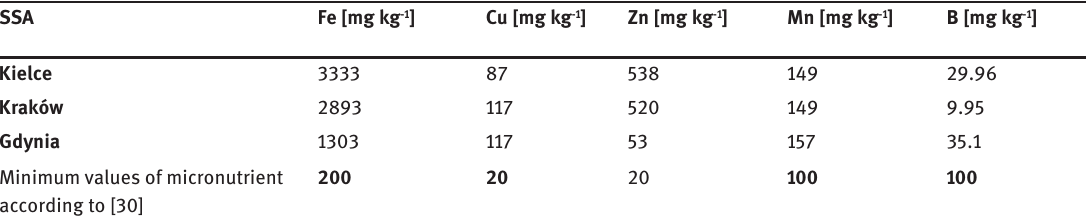
Table 5: Minimum concentration of the micronutrients declared in suspension fertilizers according to the Regulation of Minister of Economy with respect to the extract